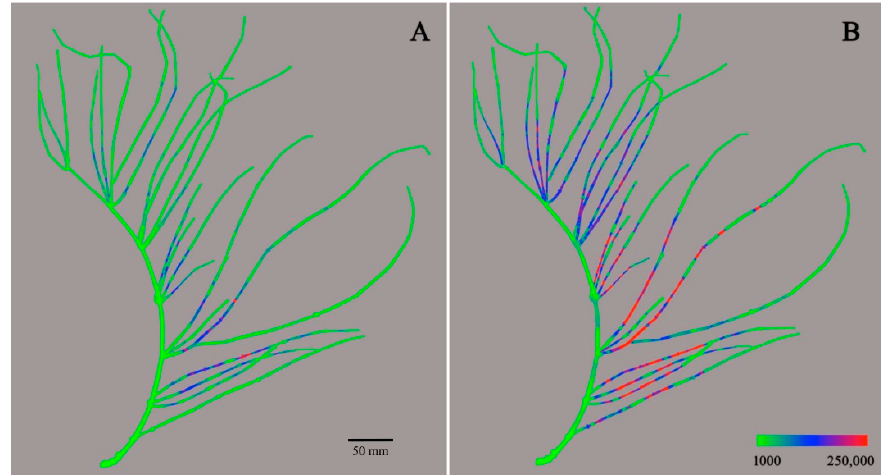
Figure 4. DART-MS molecular images for total contents of methylephedrine/methylpseudoephedrine ( m / z 180) on the outer surface ( A ) and an inner surface ( B ) of ephedra aerial part. The color range is from 1000 to 250,000 ion intensity.